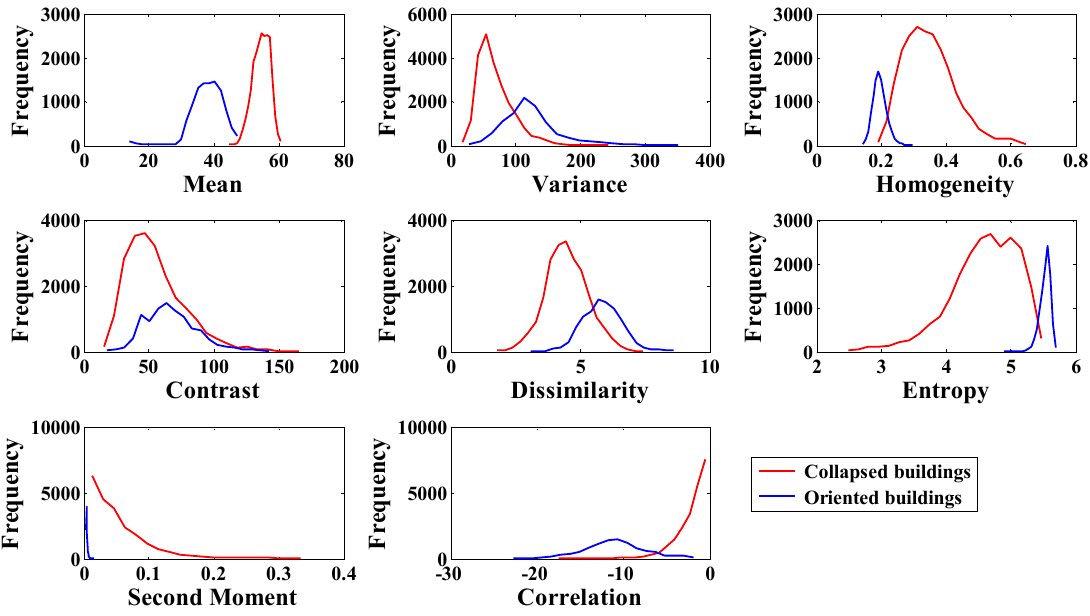
Figure 4. Comparison of the histogram curves of the collapsed building (CB) samples and the oriented building (OB) samples for eight texture features.